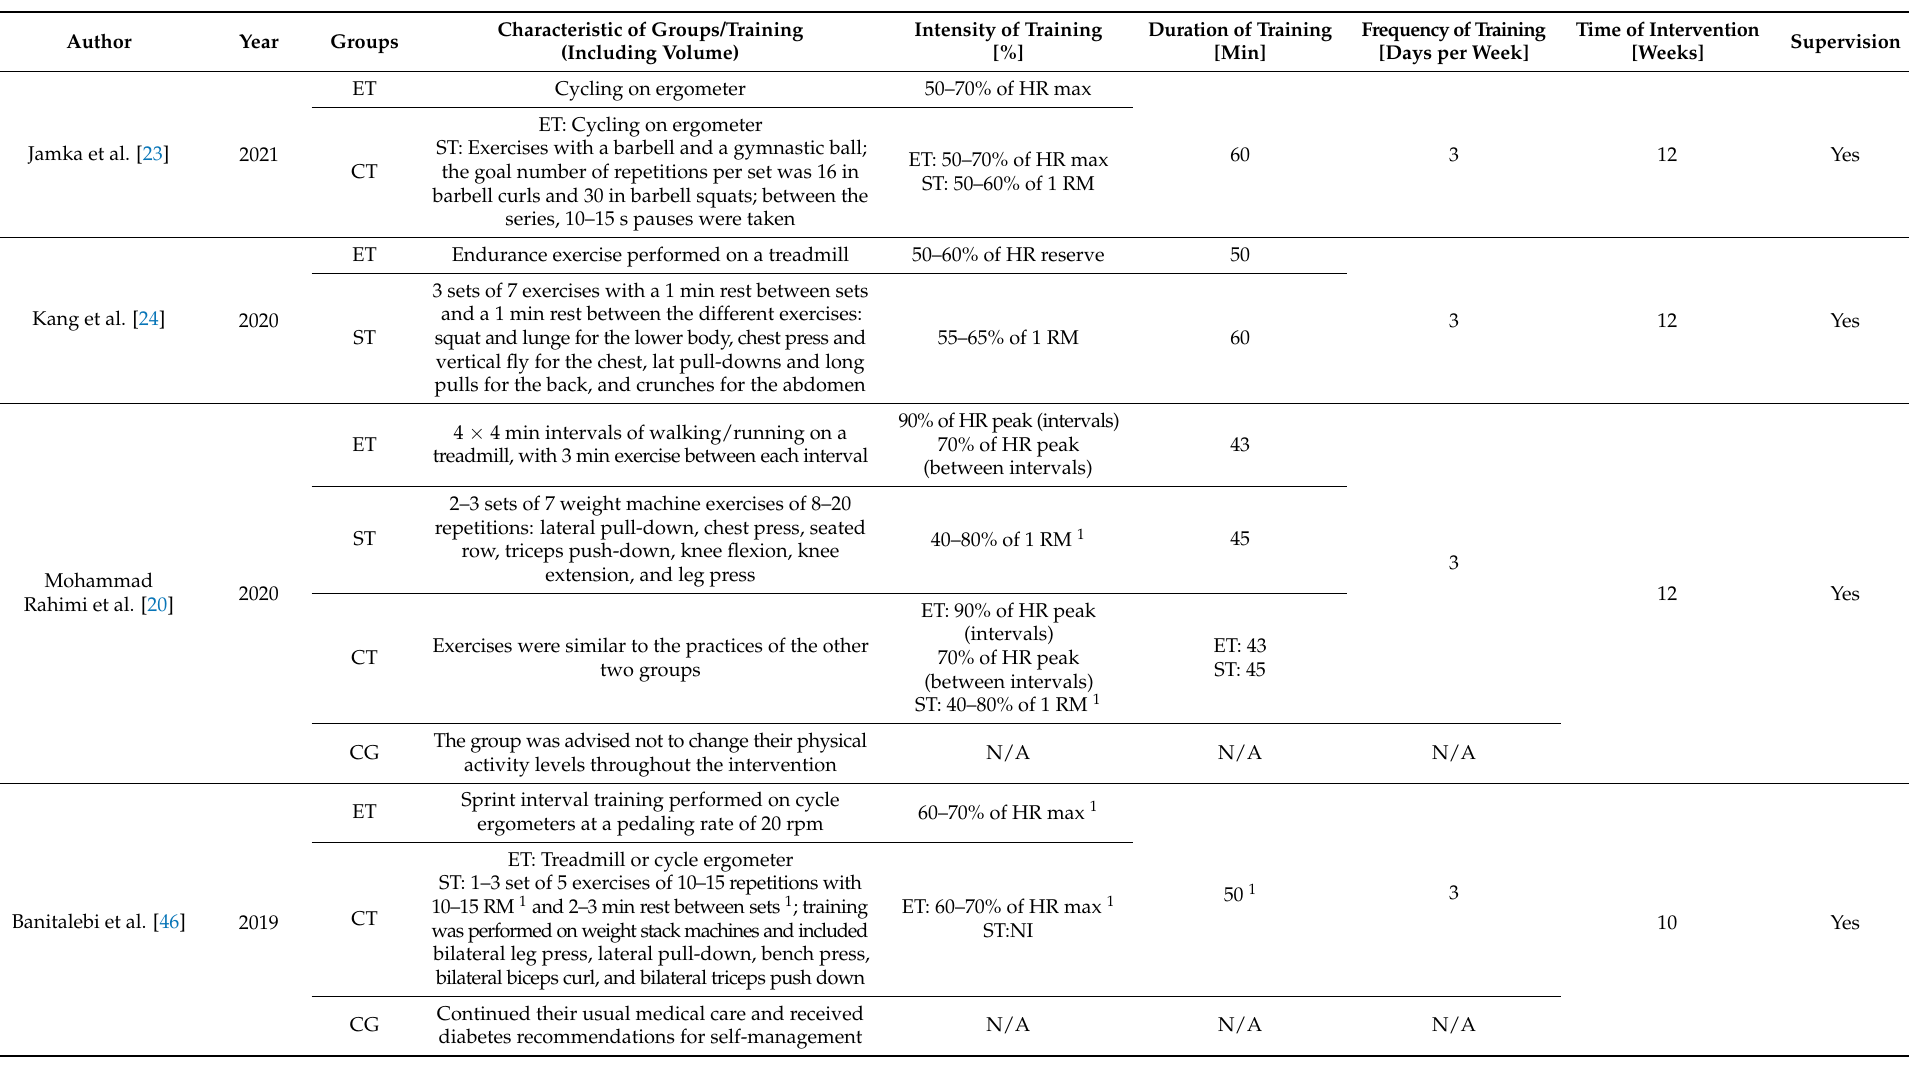
Table 2. Characteristics of training